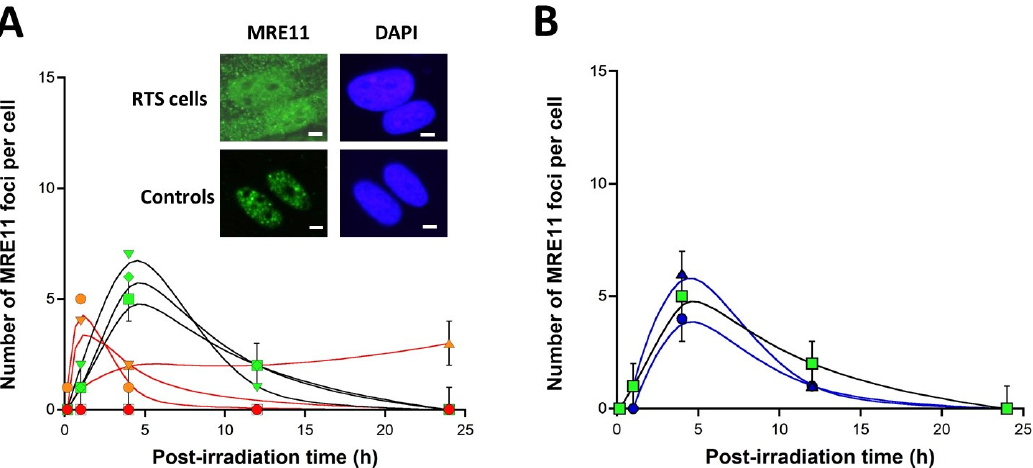
Figure 6. Kinetics of MRE11 foci in RTS fibroblasts. Anti-MRE11 immunofluorescence was applied to ( A ): the radioresistant controls (green symbols: 1BR3, squares; MRC5, diamonds; Hs27, inverted triangles), the hyper-radiosensitive ATM -mutated AT4BI (red squares) and LIG4 -mutated 180BR (red circles), and the three RTS (orange symbols: 81CLB, circles; AG17524, triangles; AG18371 inverted triangles) fibroblast cell lines and to ( B ): 2 fibroblast cell lines from the parents of RTS patients (blue symbols: AG18466, circles and AG18373, triangles) in addition to the radioresistant 1BR3 controls (green squares). The number of MRE11 foci was plotted against the post-irradiation time. Each plot represents the mean ± SEM of three replicates. Data were fitted to Bodgi’s formula [58]. The insert in panel A shows a representative example of MRE11 foci assessed 1 h post-irradiation in one RTS fibroblast cell line (81CLB) and one radioresistant control (1BR3), with the corresponding DAPI counterstaining. The white bar corresponds to 3 µm.